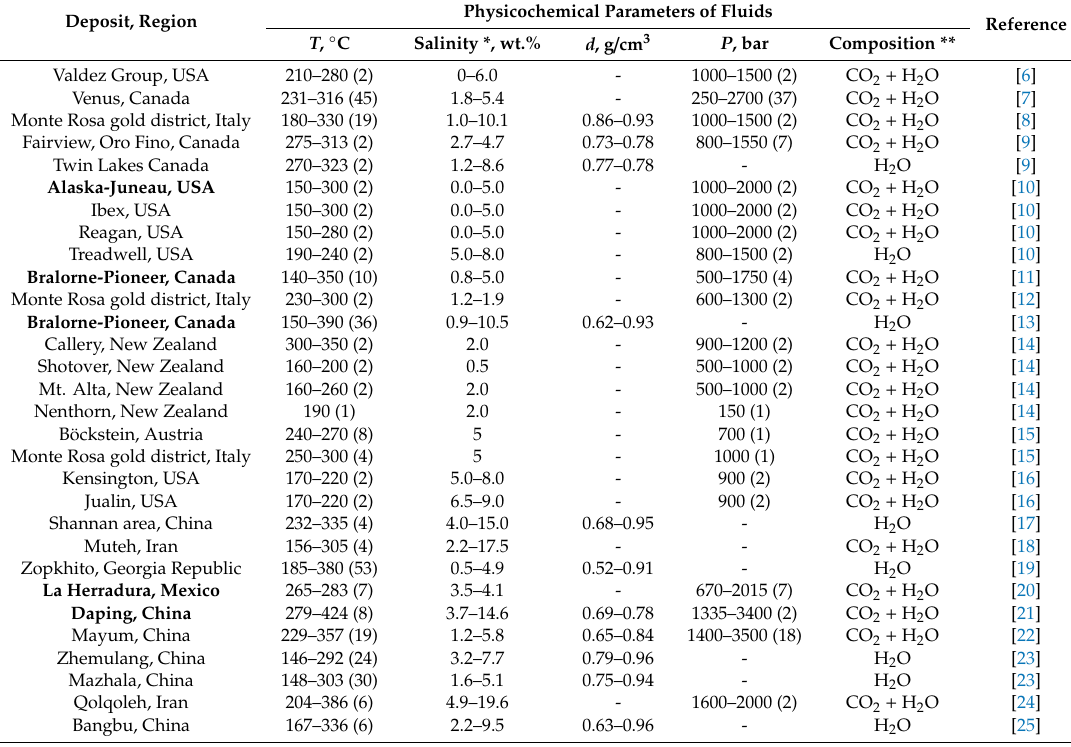
Table 2. Parameters of mineralizing fluids of Cenozoic gold